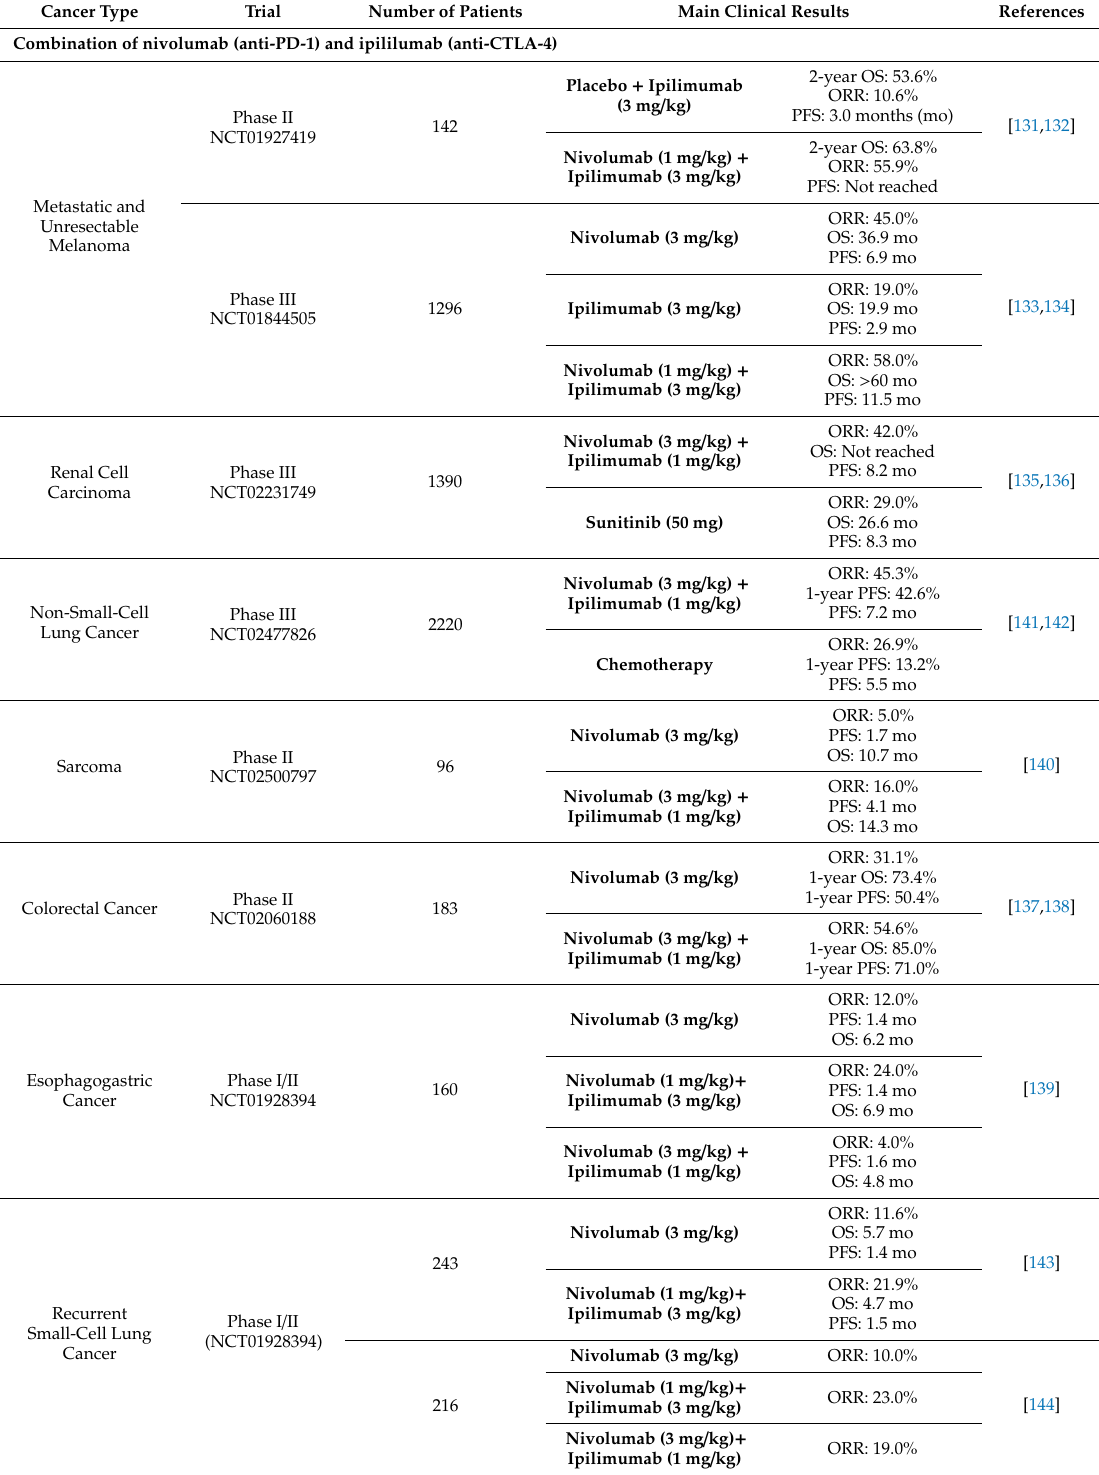
Table 5. Summary of main Phase II–III trials of anti-CTLA-4 / PD-1 / PD-L1 antibody in